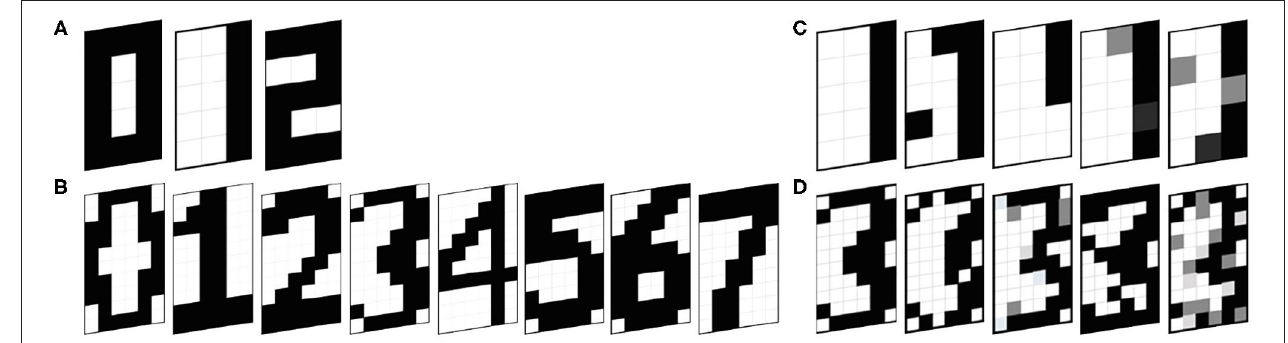
FIGURE 5 | Reference patterns for (A) 5 × 3 ONN, (B) 10 × 6 ONN, and Test sets (C) associated to digit 1 for the 5 × 3 ONN, (D) associated to digit 3 for the 10 × 6